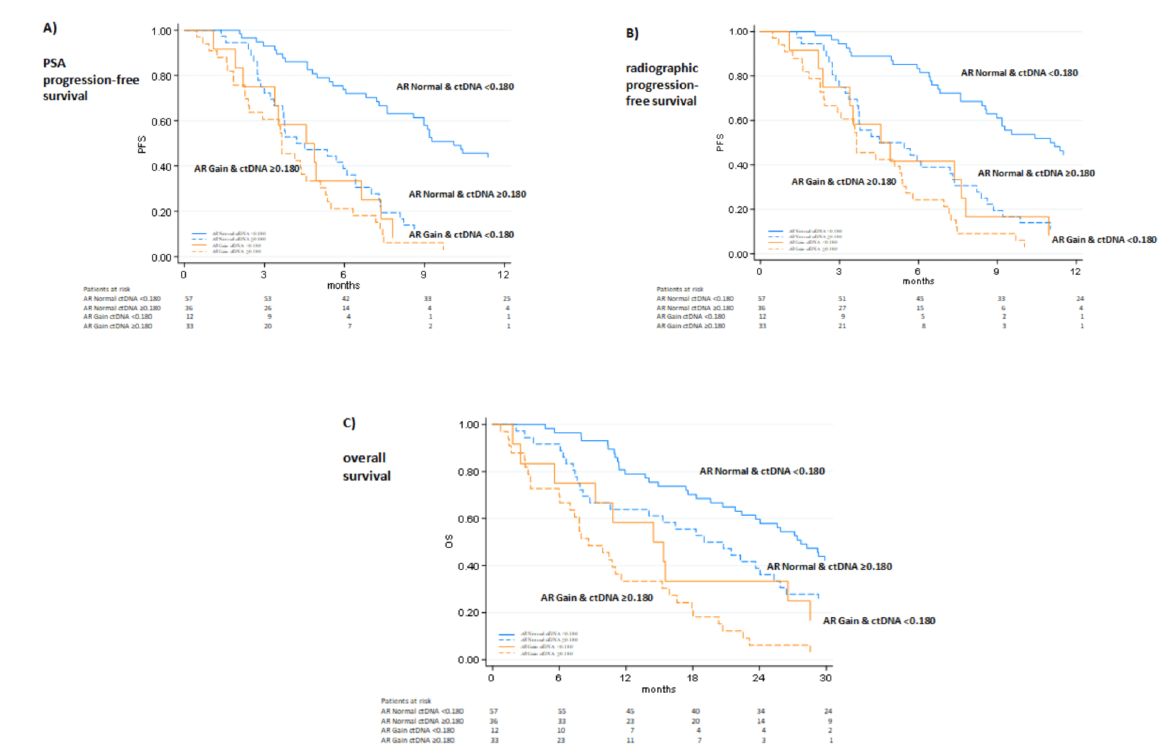
Figure 3. Combining ctDNA fraction/AR status and PSA kinetics ( A ), radiographic progression-free survival ( B ) and overall survival ( C ). Radiographic and PSA response was assessed according to PCWG3 criteria. Table 4. Multivariate analysis of PSA progression-free survival.